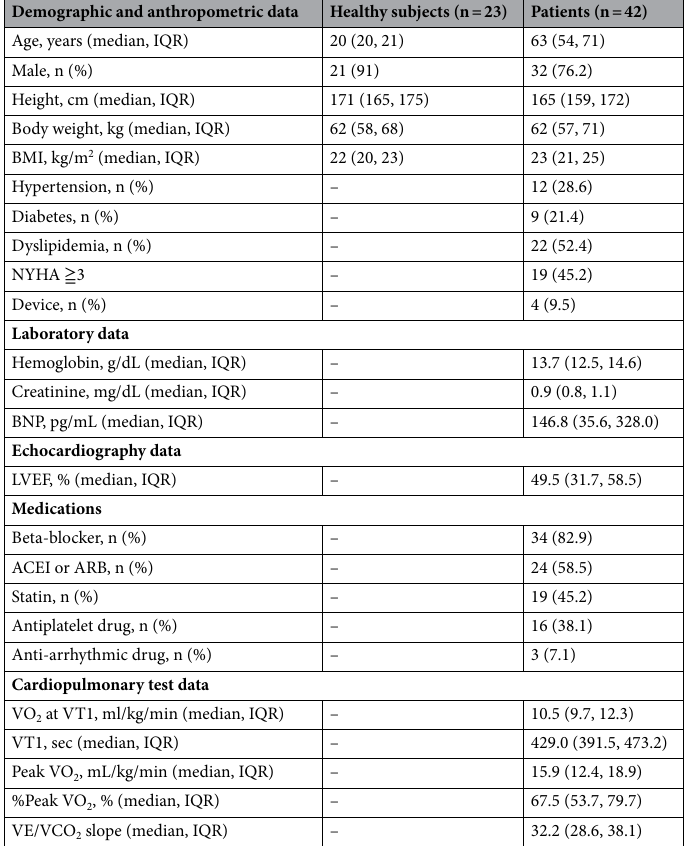
Table 1. Baseline characteristics of healthy subjects and patients. ACEI angiotensin-converting enzyme inhibitor, ARB angiotensin receptor blocker, BMI body mass index, BNP B-type natriuretic peptide, IQR